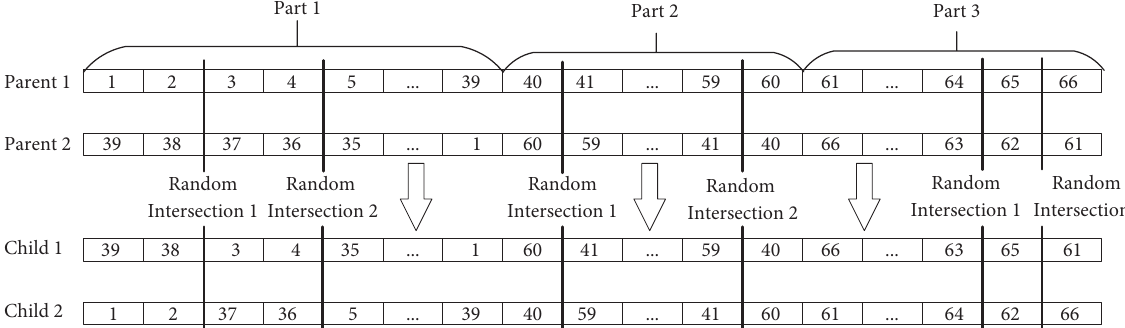
Figure 4: Block diagram of IGA.